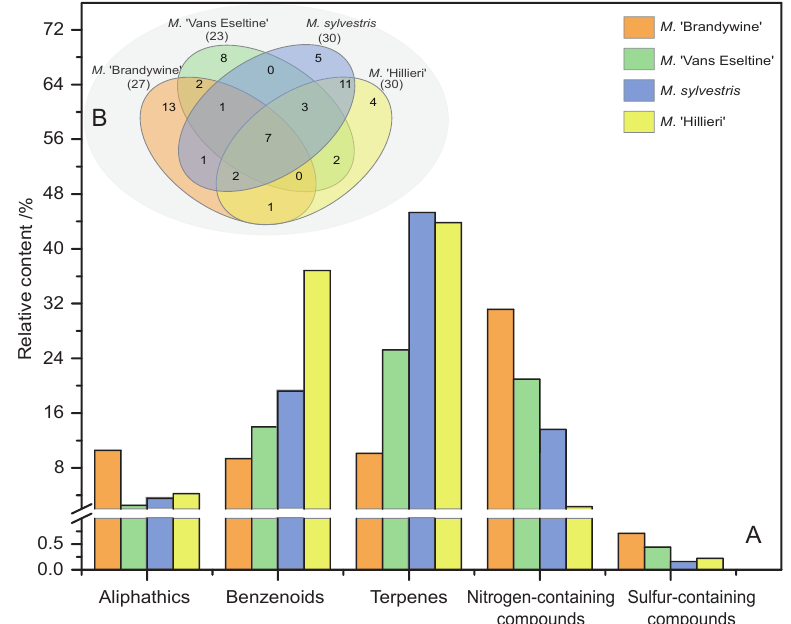
Figure 3. Statistical analysis of the volatile compounds present in the flowers of the four Malus taxa. ( A ) Compounds of different chemical classes among the four taxa. ( B ) Venn diagram indicating the similarities and differences in total volatile compounds among the different taxa. The numbers in related overlapping areas indicate the compounds shared between the different